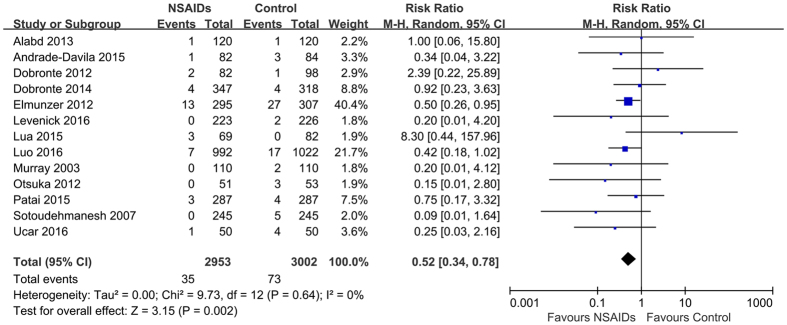
Forest plot showing a significant reduction in the risk of moderate to severe post-ERCP pancreatitis with rectal NSAIDs therapy.CI, confidence interval; M-H, Mantel-Haenszel; NSAIDs, nonsteroidal anti-inflammatory drugs; ERCP, endoscopic retrograde cholangiopancreatography.